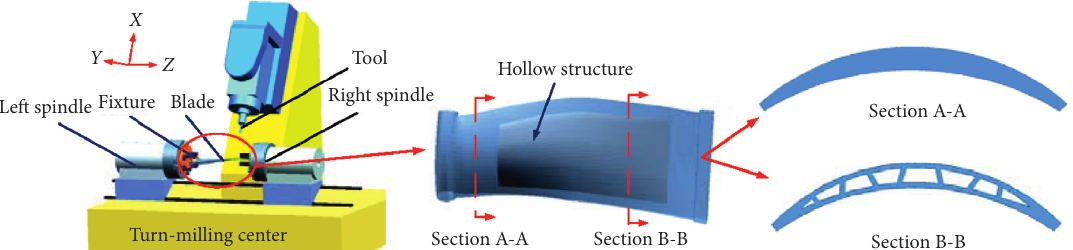
Figure 1: Turn-milling of the hollow blade with